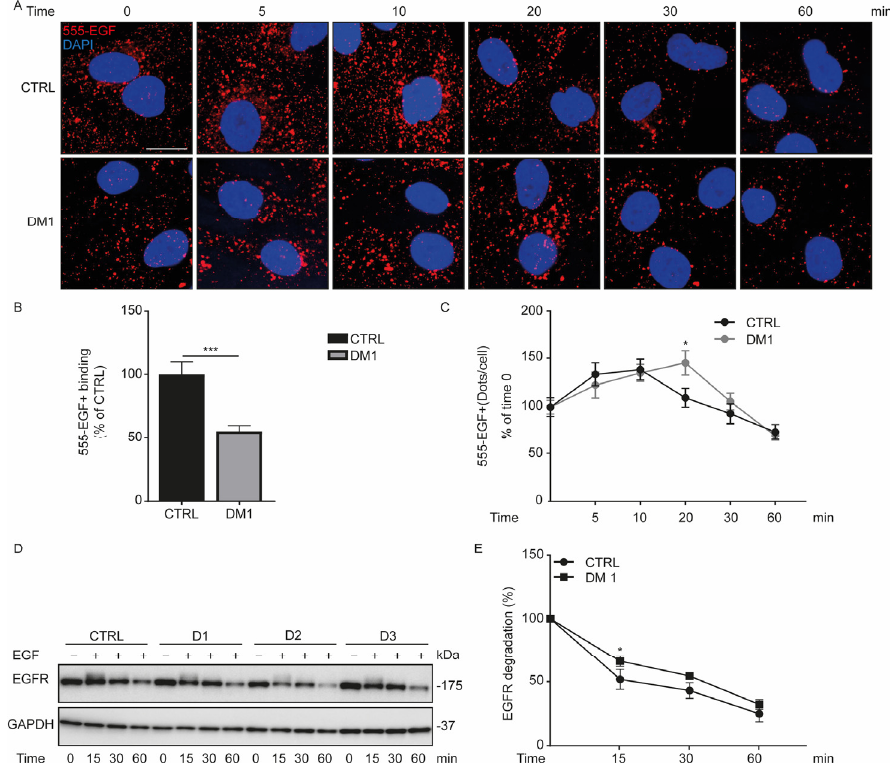
Figure 5. EGFR internalization decreases in DM1 cells. ( A – C ) Serum-starved CTRL and DM1 cells were incubated with 100 ng/mL Alexa-555-EGF (555-EGF) for 30 min on ice. After washing, cells were incubated at 37 °C for the indicated times (0, 5, 10, 20, 30, and 60 min) and then fixed. ( A ) Representative images of the fluorescent EGF (555-EGF), nuclei were stained with 300 nM DAPI (scale bar is 10 µ m; original magnification is × 60). ( B ) Data are the percentage of 555-EGF + dots ± SEM per cell at time zero (*** p < 0.001 with Student’s t -test), reflecting the binding of the ligand. ( C ) Data are the percentage ± SEM of 555-EGF + relative to time zero (* p < 0.05 DM1 versus CTRL cells at 20 min, with a multiple Student’s t -test), reflecting the trafficking and degradation of the fluorescent EGF. ( D , E ) CTRL and DM1 were starved overnight and then incubated at different time points (0, 15, 30, and 60 min) with 100 ng/mL EGF. The EGFR protein level was normalized to GAPDH, and the percentage was determined relative to time zero. ( E ) Data are the mean percentage ± SD of EGFR degradation at the indicated times (* p < 0.05, with multiple Student’s t -tests). To corroborate the defect in the endocytosis trafficking of 555-EGF in DM1 cells, we assessed the EGFR protein level in HFs upon EGF ligand stimulation. Serum-starved cells were treated with 100 ng/mL EGF for 15, 30, and 60 min (Figure 5D). EGF treatment via the endocytic pathway. At time zero, the level of EGFR protein between CTRL and DM1 cells was similar (100 ± 15.81 vs. 101.44 ± 32.44, respectively). Nevertheless, the